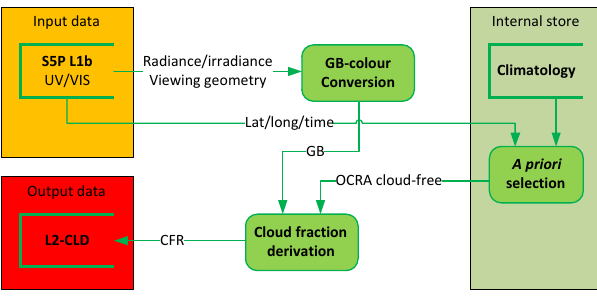
Figure 1. Flow diagram for the OCRA algorithm for the retrieval of the radiometric cloud fraction